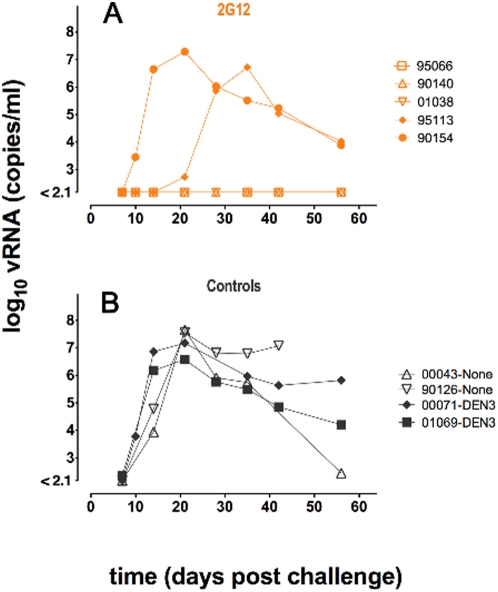
Plasma viral loads following SHIVSF162P3 vaginal challenge of 2G12-treated and control macaques.A total of nine female Indian rhesus macaques were divided into treatment groups of five animals for i.v. administration of 2G12, two animals to receive the isotype control (Dengue anti-NS1, DEN3), and two additional controls were challenged prior to the beginning of the protection study to confirm viral fitness, but were not treated with antibody. In (A) two 2G12-treated (40 mg/kg) animals became infected: 90154 reached peak viremia of 2×107 on day 21 similar to controls; 95113 showed a one-week delay of infection onset and peak viremia was lower at 5×106. The remaining three 2G12-treated animals were protected against infection and showed no measurable viremia. In (B) all 4 control animals experienced peak viremia between 1×107 and 4×107 on day 21. The quantity of SIV viral RNA genomic copy equivalents (vRNA copy Eq/ml) in EDTA-anticoagulated plasma was determined using quantitative RT PCR [52]. The assay minimum detection is 150 copies of vRNA Eq/ml (2.1 log) with a 99% confidence level.